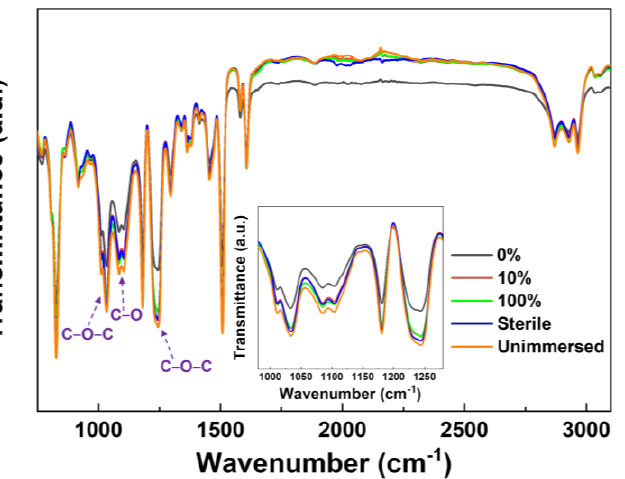
Figure 7. FTIR spectra of the samples after 14 days of immersion in the sterile and inoculated culture media with 100%, 10%, and 0% nutrients.